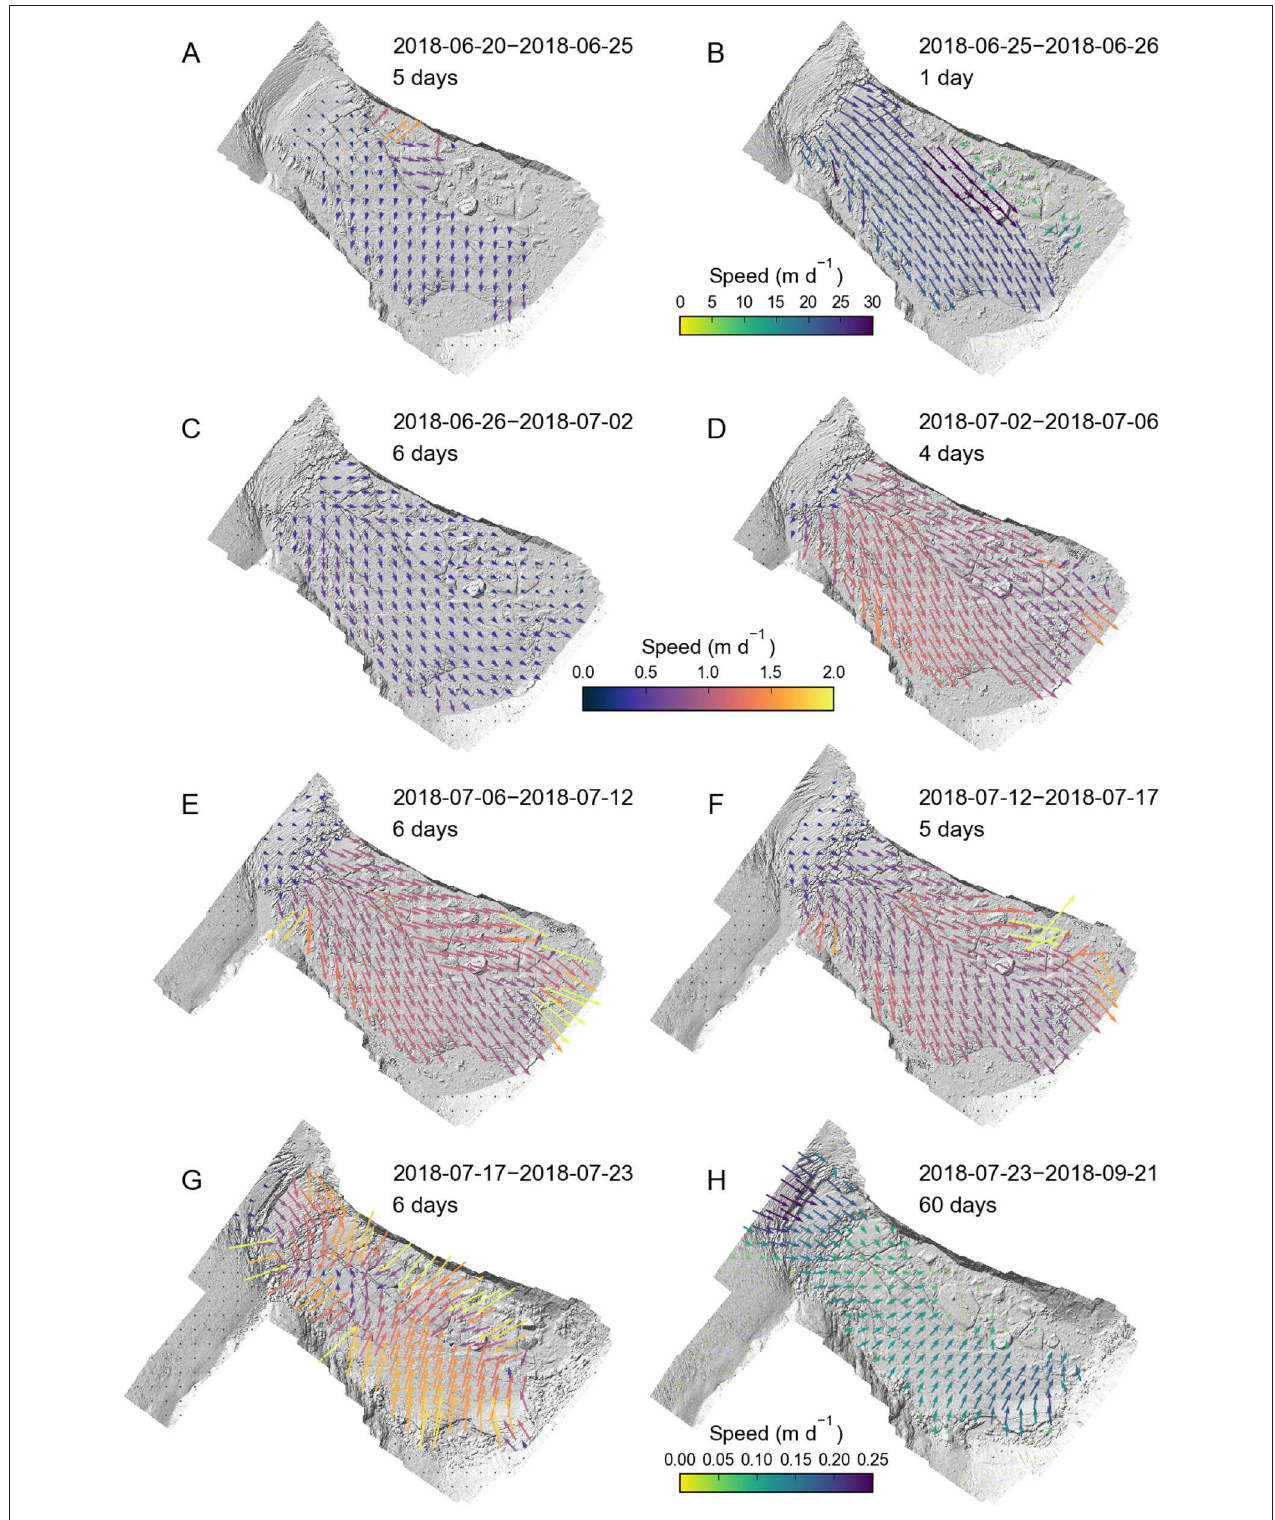
FIGURE 11 | (A–H) Velocity time series derived from eight consecutive DEM pairs captured during summer 2018. Except for (B,H) , the same vector scaling and colorbar (purple-red tones) applies across the panels. Panel (B) , covering the calving event, and panel (H) covering the post-drainage period, capture periods with increased/reduced displacements, and thus feature their own vector scaling and colorbar in green-blue tones.